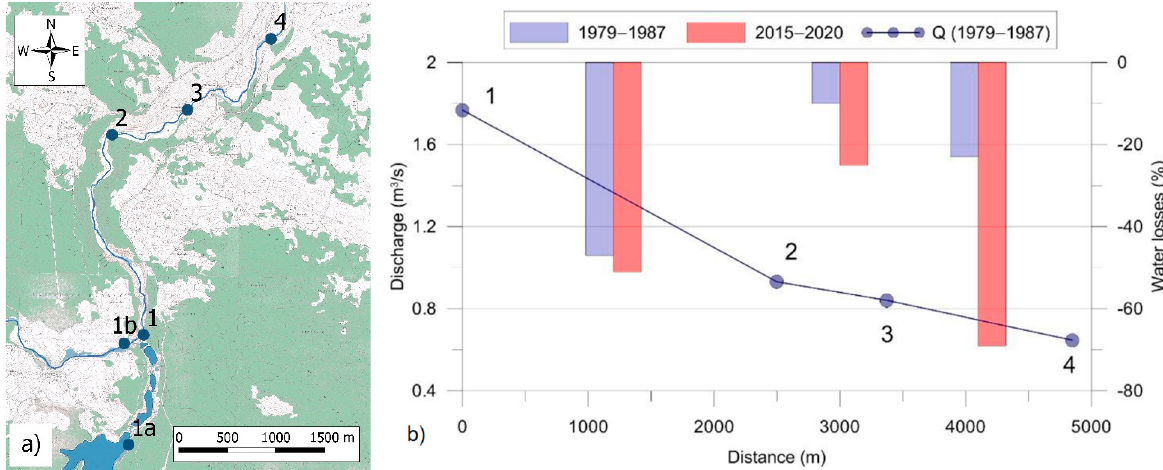
Figure 10. ( a ) Positions of discharge measurement profiles (1—beginning of the Korana course (1a Kozjak Lake and 1b Plitvica); 2—Lajtmanov Slap; 3—Luketi ć i; 4—Korana Most). ( b ) Mean discharges for the 1978–1987 period in comparison with the losses between discharge measurement profiles for the two periods, 1978–1987 and 2015–2020.